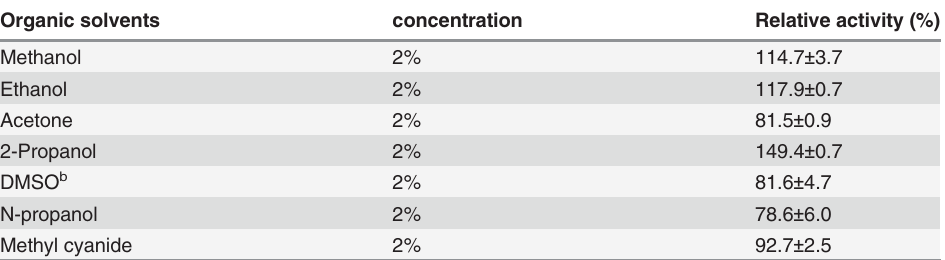
Table 3. Effect of organic solvents on enzyme stability after incubation at 45°C for 1 h. Organic solvents concentration Relative activity (%) Methanol